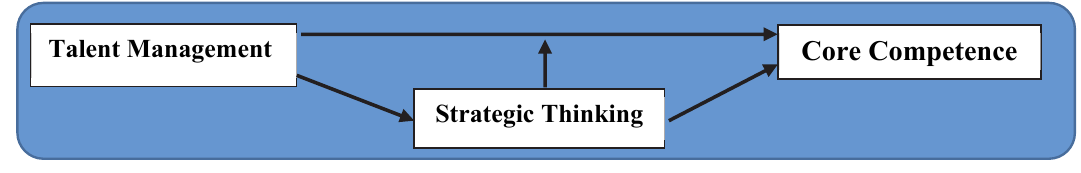
Fig. 1. Study Theoretical